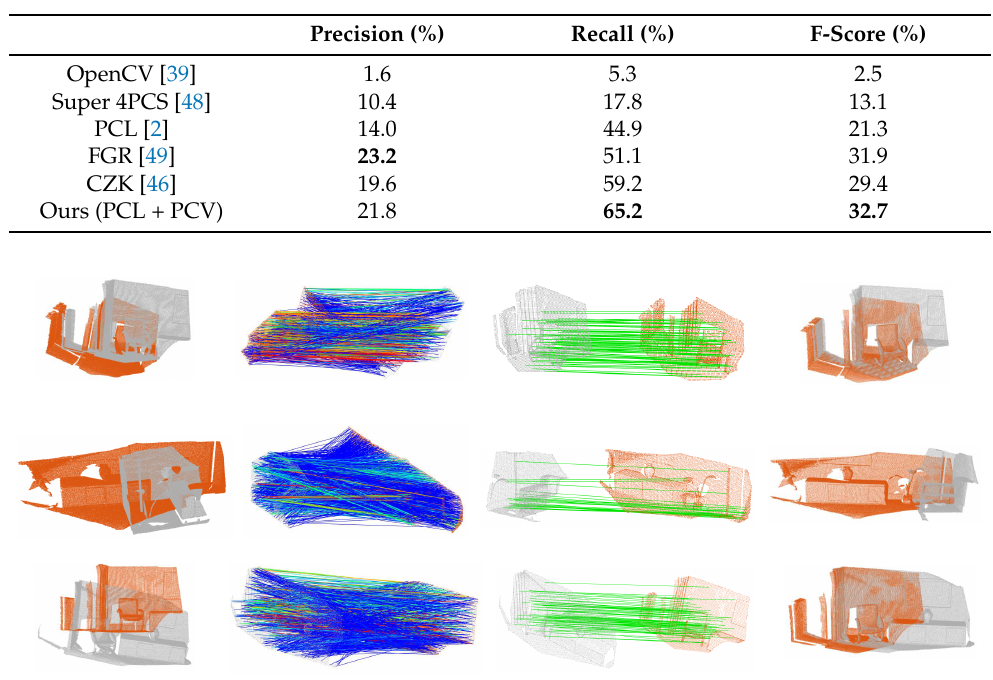
Table 5. 3D scene registration performance on the Aug_ICL-NUIM benchmark [46].